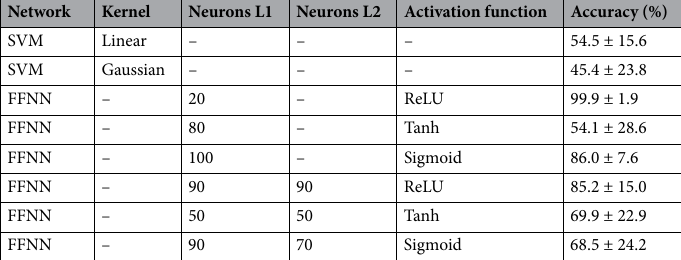
Table 1. Performance with the chosen set of hyper parameters for all the tested networks.